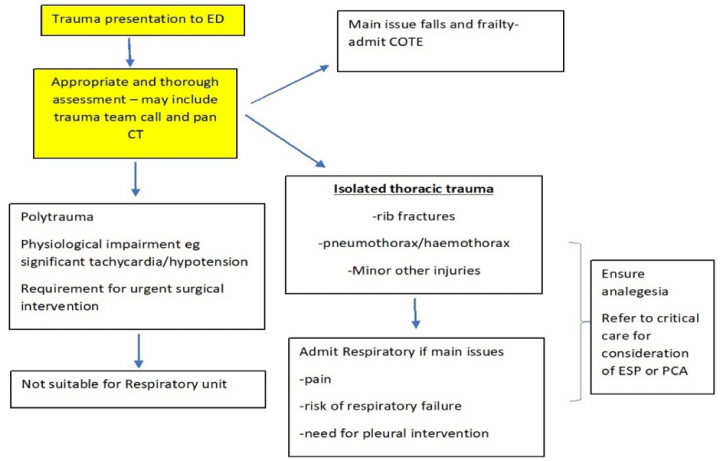
Figure 1. Local decision pathway for trauma